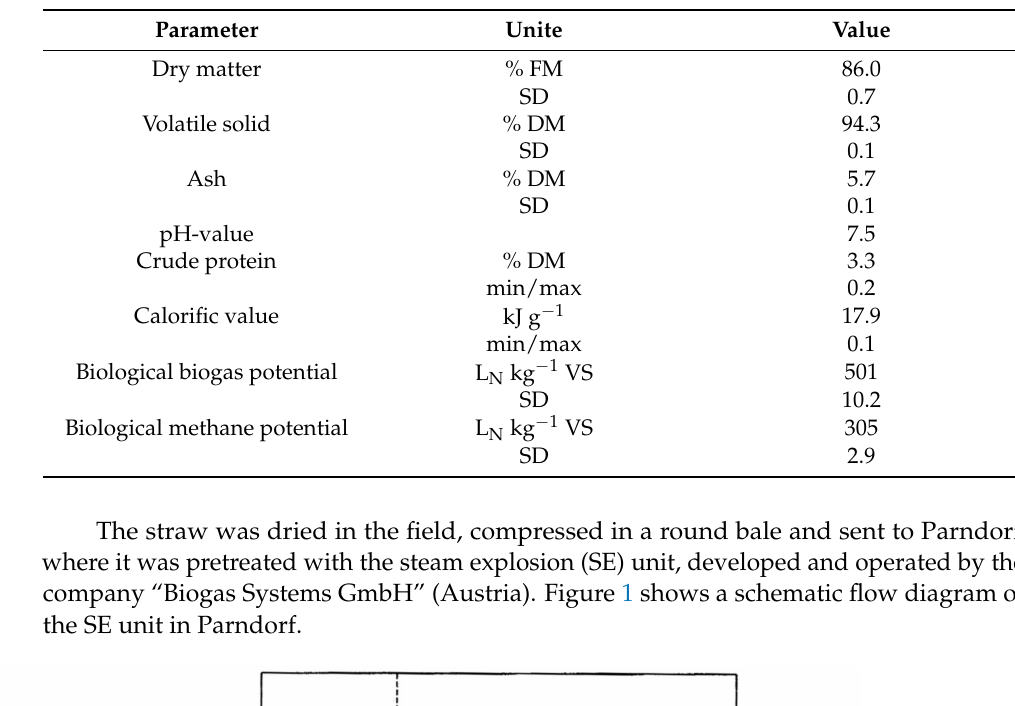
Table 1. Composition of untreated maize stover.